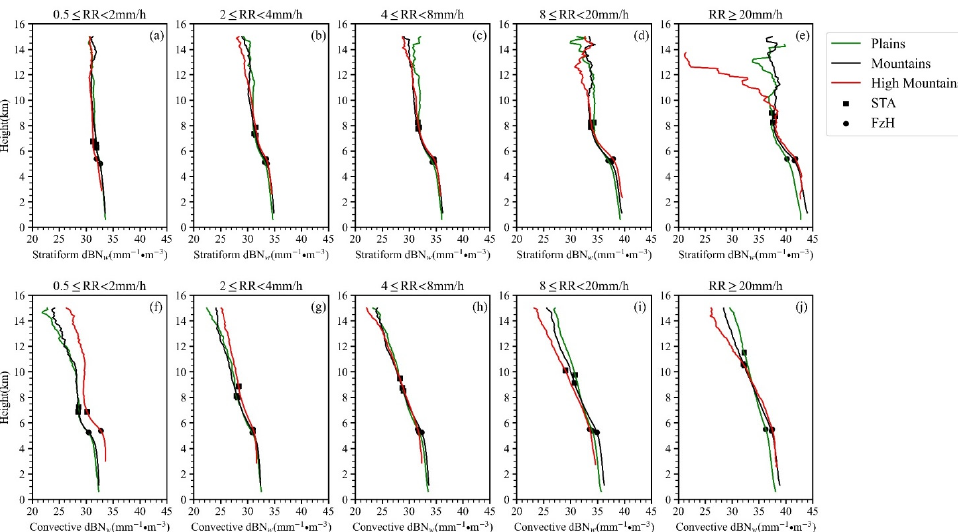
tics of lower number concentration and larger scale above 10 km.